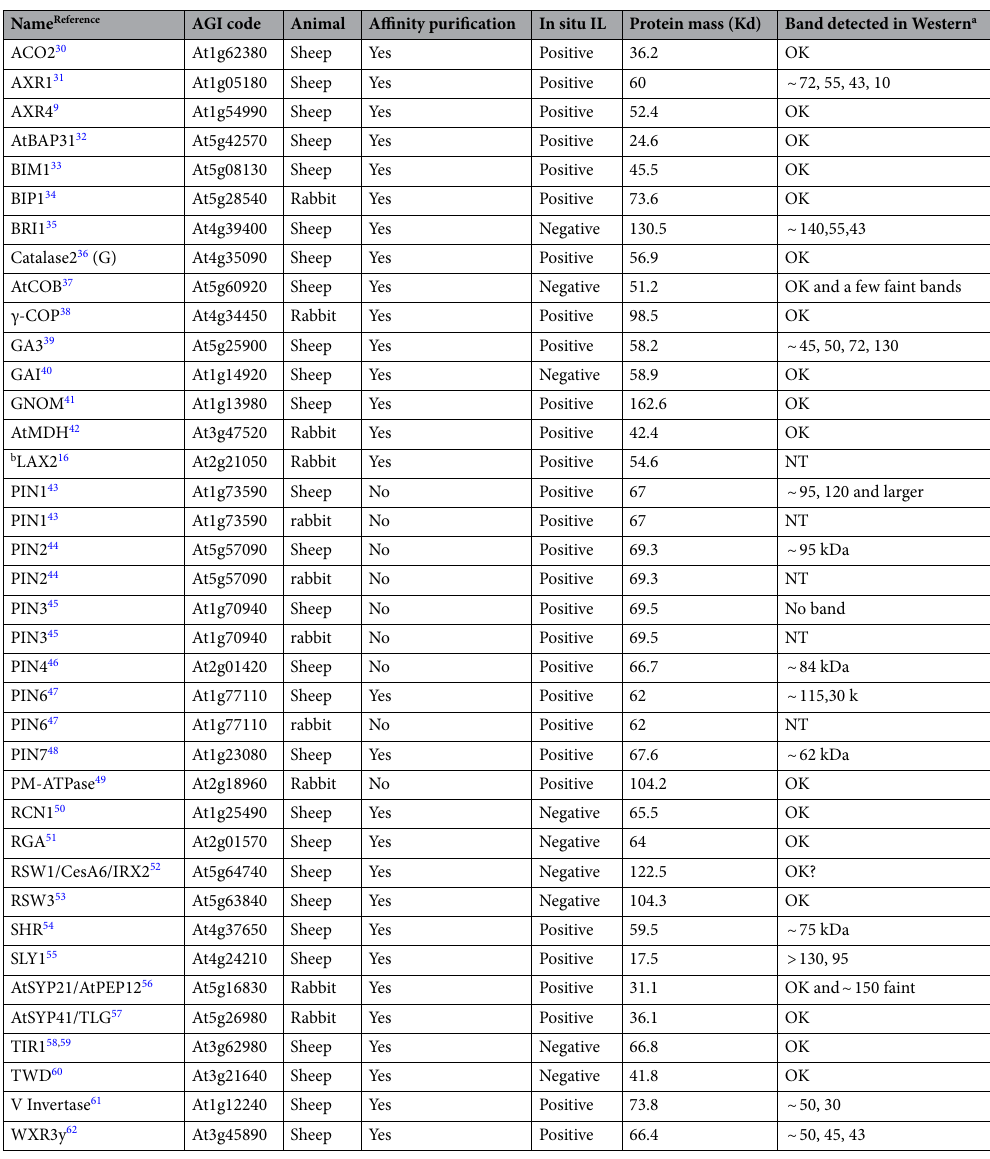
Table 1. List of successful antibodies raised in CPIB antibody project. a Single correct size bands are indicated as ‘OK’. Where bands do not match the correct size or there are multiple bands, approximate band sizes (kDa) are indicated. NT not tested. b Peptide